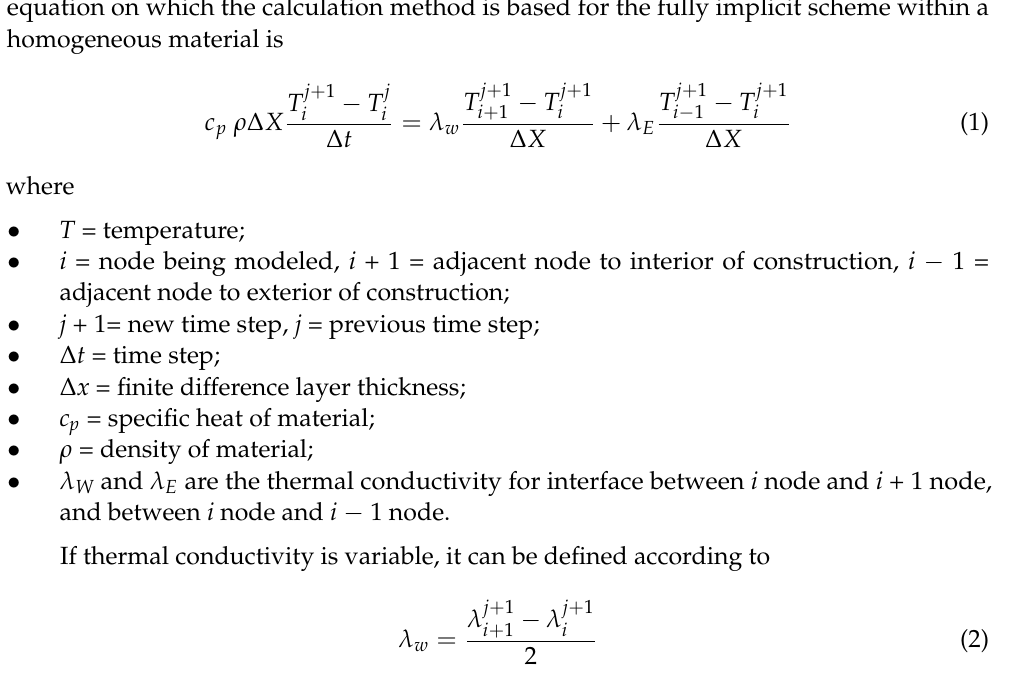
Figure 5. Enthalpy–temperature function of MOC with integrated PCM.